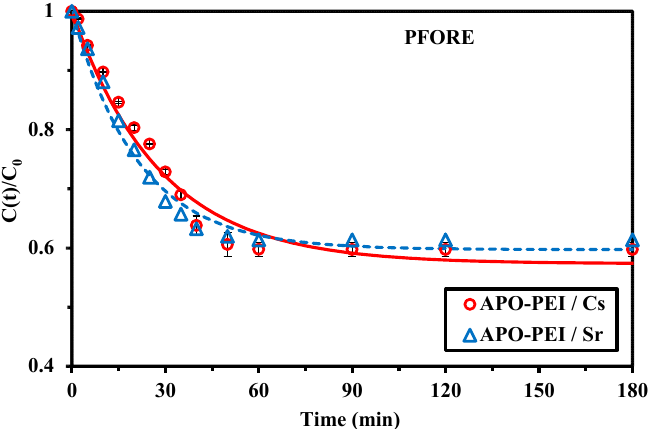
Figure A12. Uptake kinetics for Cs(I) and Sr(II) sorption using APO-PEI sorbents from binary solution (C 0 : 0.751 mmol Cs L − 1 and 1.148 mmol Sr L − 1 ; sorbent dose, SD: 0.67 g L − 1 ; v: 210 rpm; pH 0 : 7; T: 21 ± 1 °C).